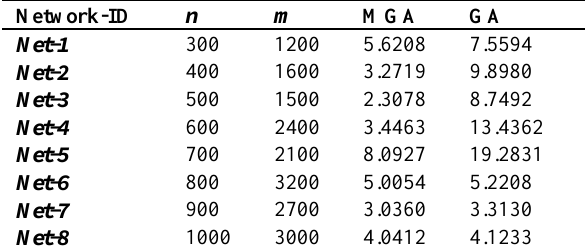
Table 2. RE Results of GA, MGA on random networks